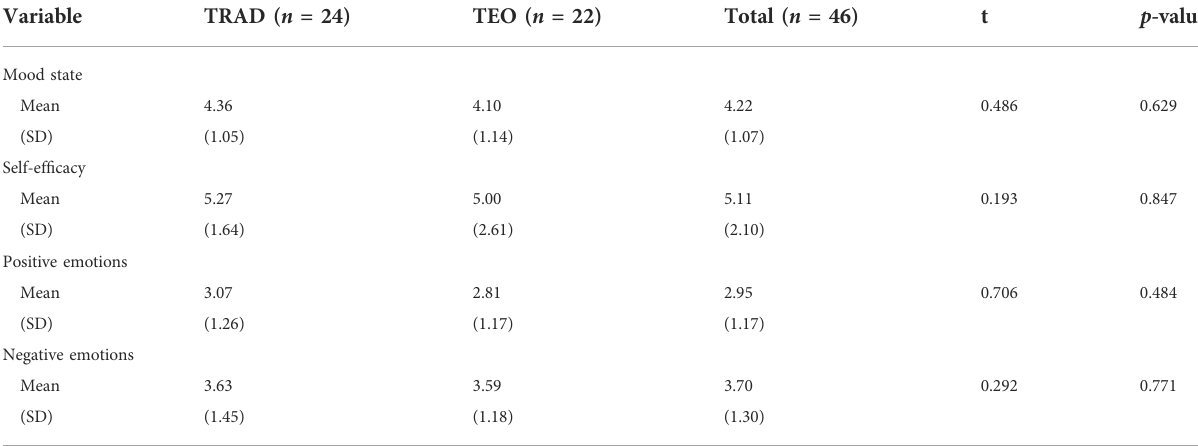
TABLE 2 Means and standard deviations obtained for mood, self-ef fi cacy, and emotional variables in the two experimental conditions on the pre- homework time in the fi rst therapy session. Variable